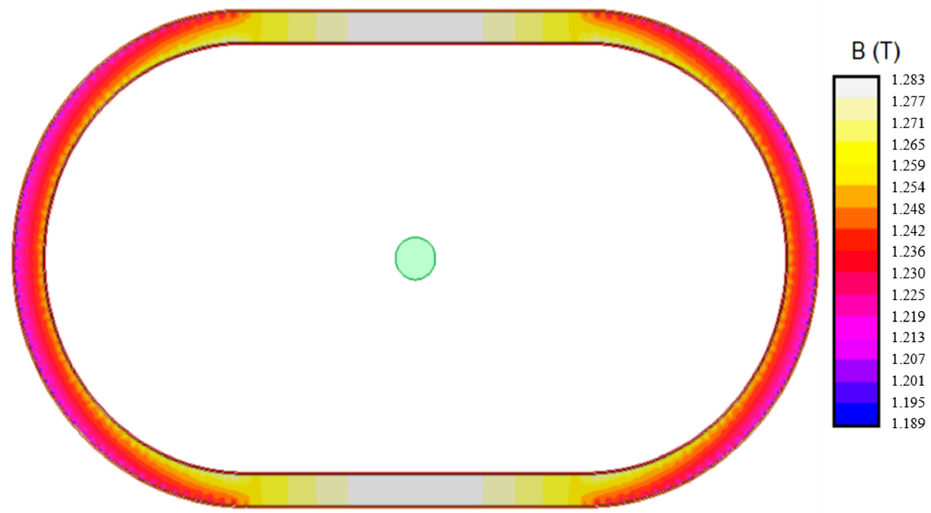
Figure 9. Flux density. Current transformer 500 / 1A 5P10 1VA. Distributed secondary winding. Primary current 5002 A, secondary current 9.719 A.